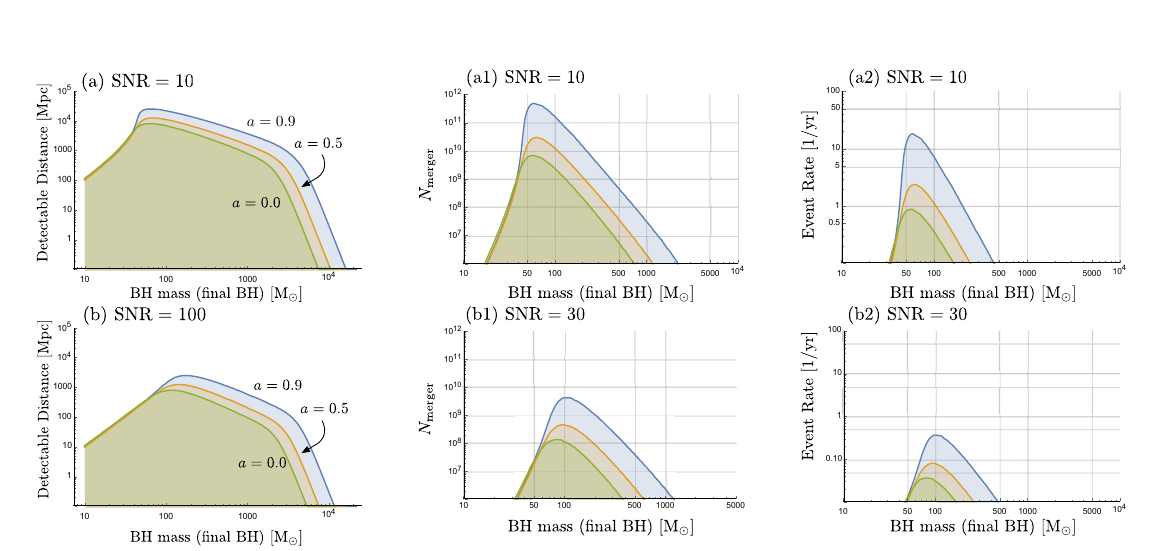
Figure 3. (left) Detectable distance D of the ring-down signal at KAGRA. S / R is set to (a) 10 and (b) 100. (middle and right) Number of BH mergers within the detectable distances (a1, b1) and event rate R (a2, b2) as a function of BH mass M with S / N ratio ρ = 10 and 30 for KAGRA. Three distributions for each figure are of a = 0 . 9 , 0 . 5 , and 0 . 0 (from largest to lowest), respectively.